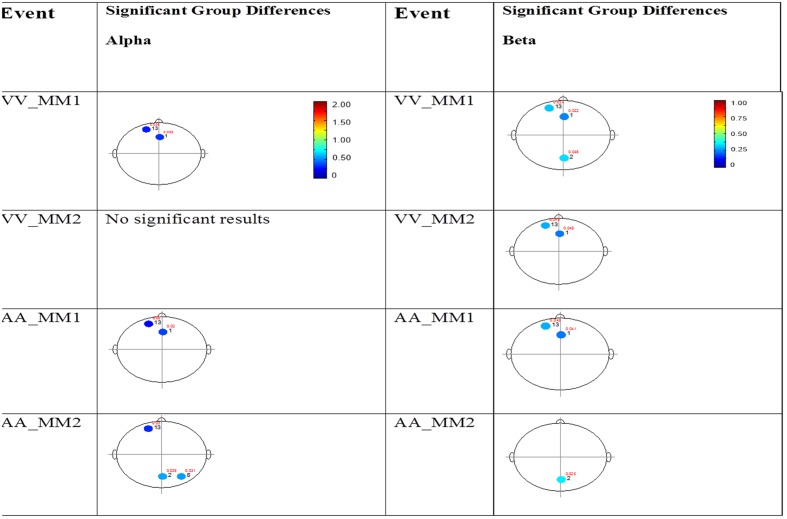
Session 2 alpha and beta EEG power group differences-multimodal presentations. Results for the alpha band (left) and beta band (right) are presented. Significant differences were determined using the Tukey–Kramer method for p < 0.05.